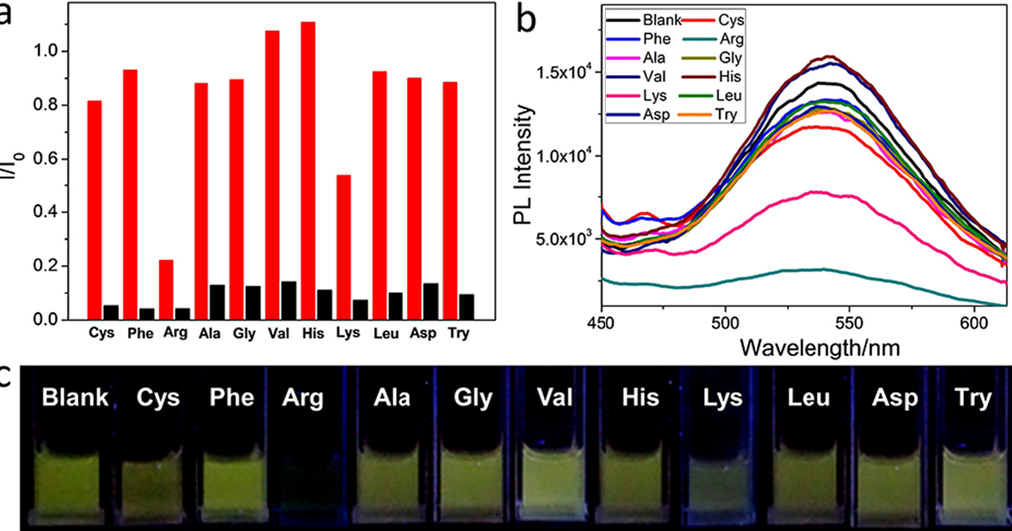
Figure 7. ( a ) The red bars represent the addition of various amino acids to the solution, and the black bars indicate the subsequent addition of Arg to the above solution. ( b ) The luminescence spectra of the Ag 6 @C 16 mimNCs solution after adding different amino acids. ( c ) The photo of the Ag 6 @C 16 mimNCs solution under UV lamp after adding different amino acids. Copyright 2019